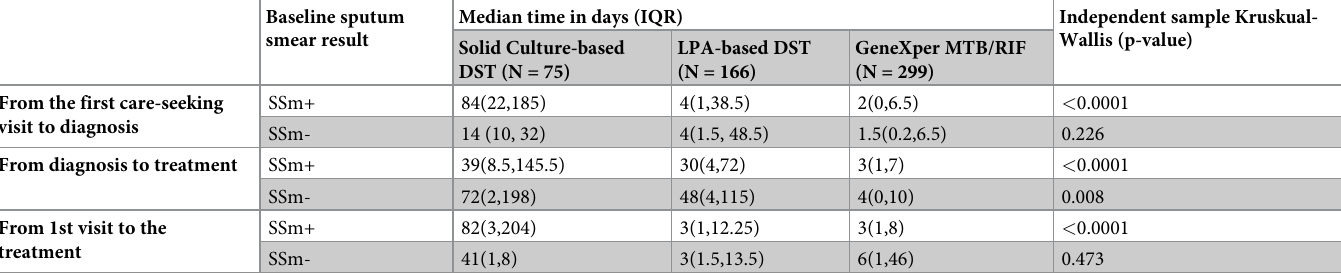
Table 3. Median time from the first care-seeking visit to diagnosis and treatment, and diagnosis to treatment by their sputum smear status among DR-TB patients in Amhara region, Ethiopia